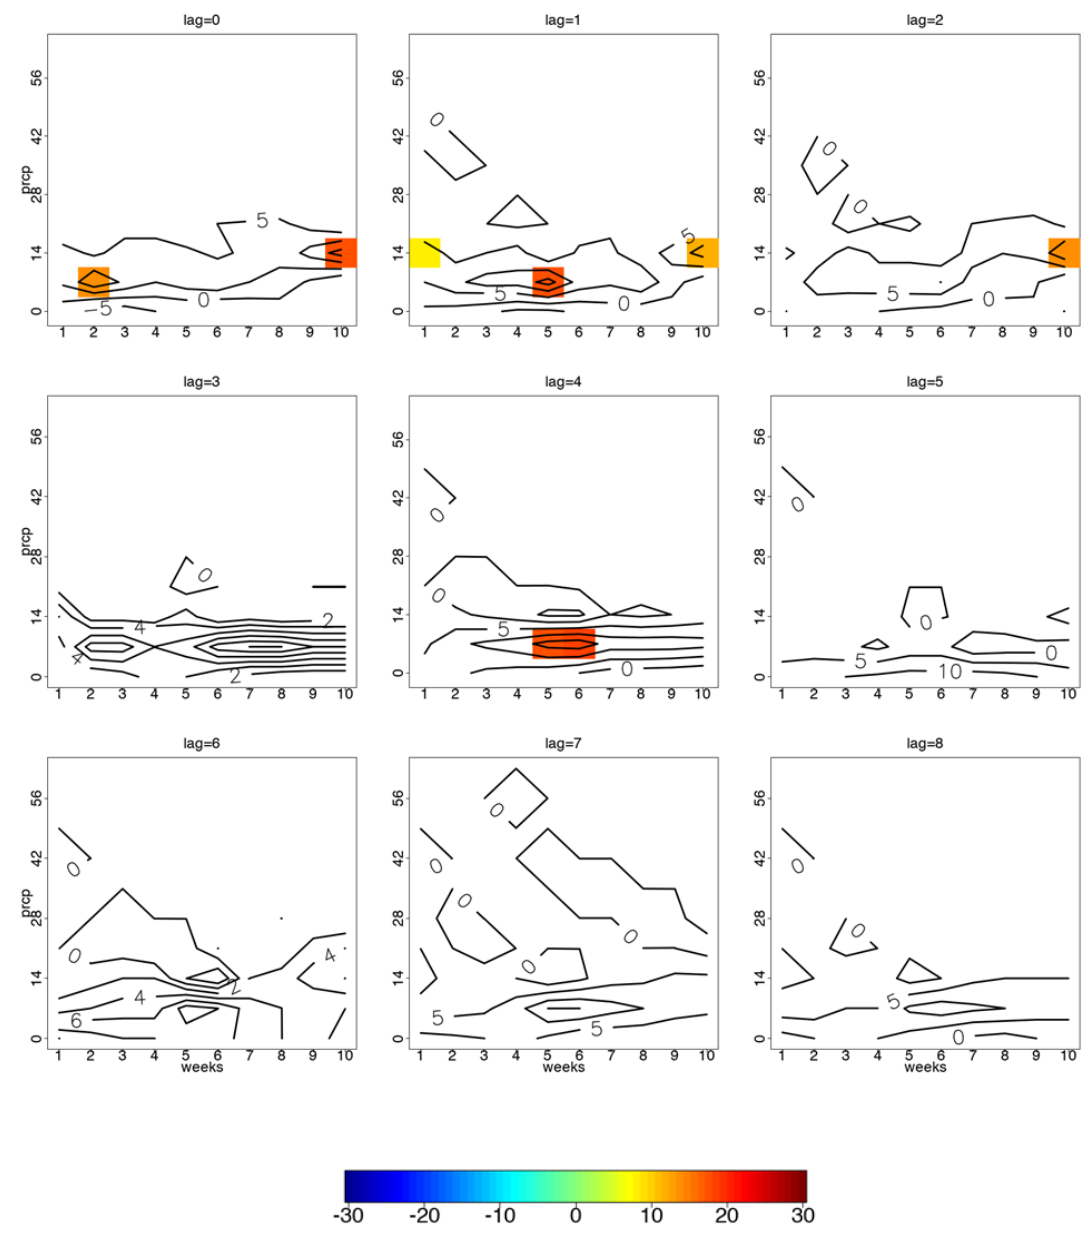
Figure 4. Statistically significant contour di ff erences in anomalously high and low diarrhoea case counts for lag 0 to 8 weeks per consecutive weeks of precipitation among individuals aged 5 years and older for season SON. X-axis represents number of consecutive weeks in which the average precipitation reached over Y-axis representing rainfall in millimetres (mm). Warm colours represent higher frequency of (X, Y) occurring when diarrhoea case counts were anomalously higher than